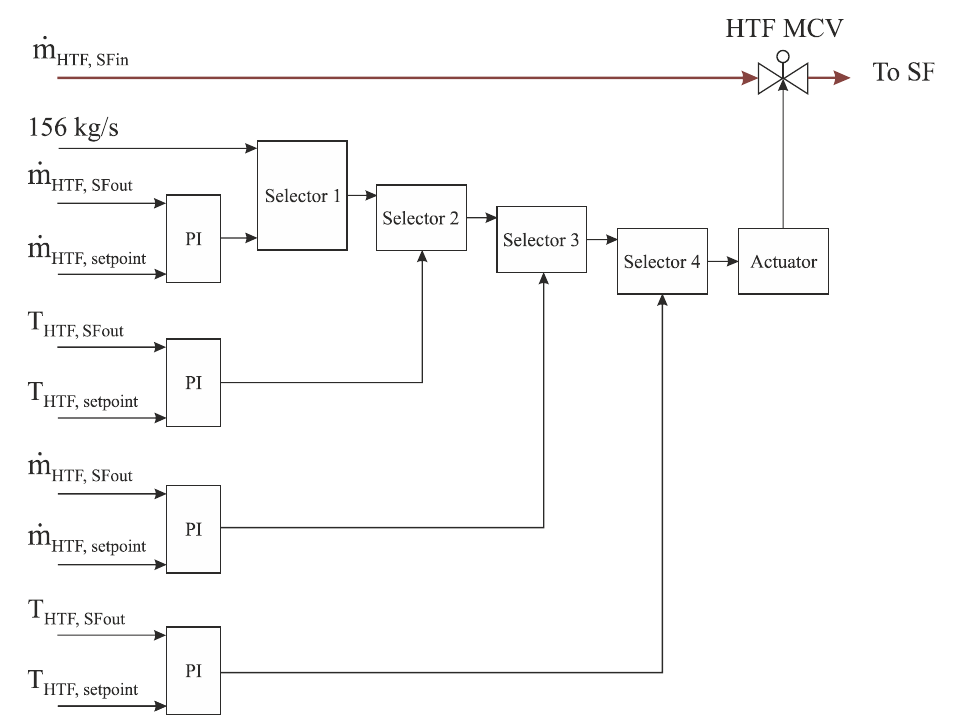
Figure 3. HTF main control valve at the inlet of the SF (simplified).